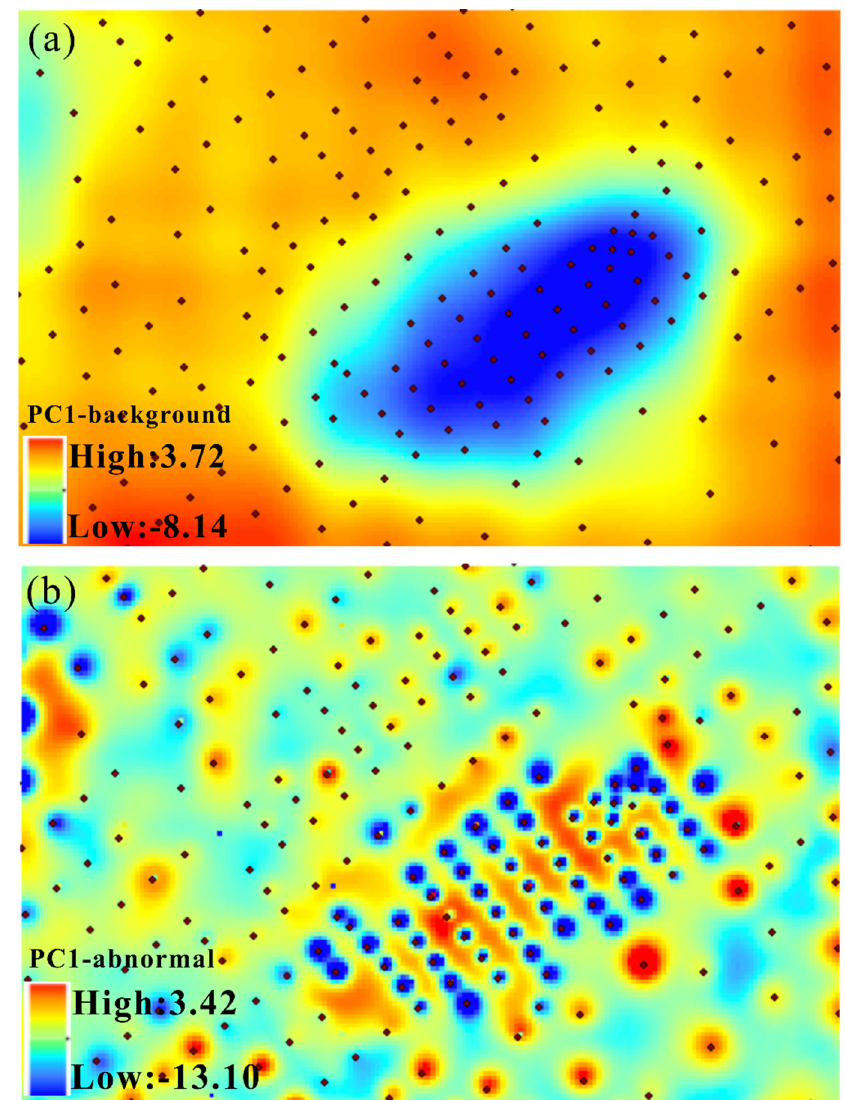
Figure 8. Background values of scores on the first principal component ( a ) and anomalies of scores on the first principal component ( b ).